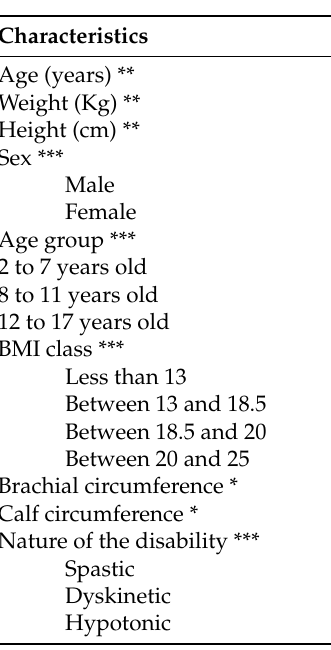
Table 1. Sociodemographic and clinical data of